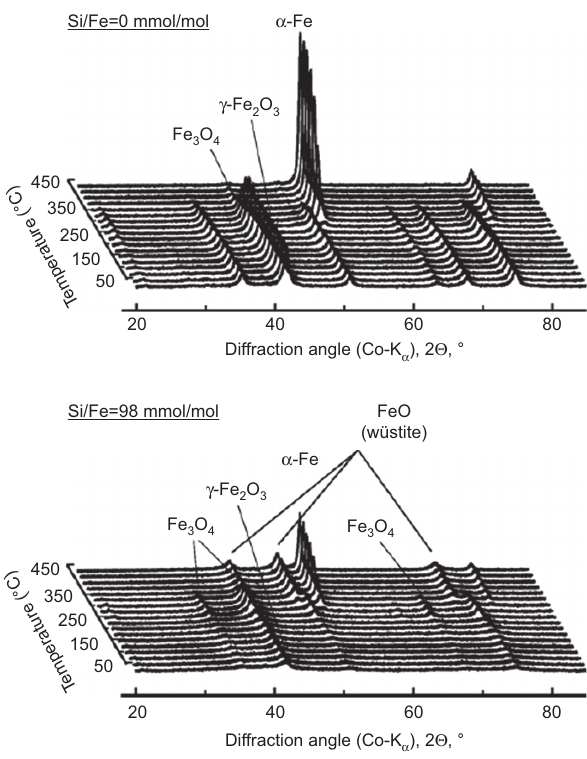
Figure 5 In situ XRD of the hydrogen reduction of the unmodi- fied sample (top) and the sample containing 98 mmol Si/mol Fe (bottom). Reduction: pure hydrogen, 400 ml (NTP)/min/g; heating rate: 0.5 ° C/min – only main diffraction peaks indicated (Reprinted from ref [19]. Copyright (2012), with permission from